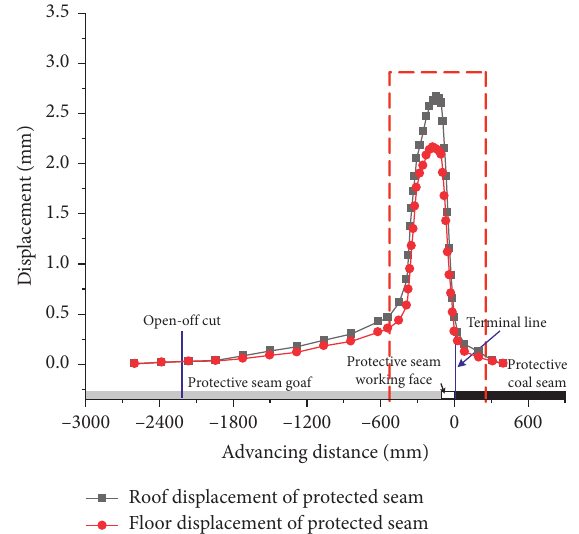
Figure 22: Displacement curve of the top and bottom plates of the protected layer.